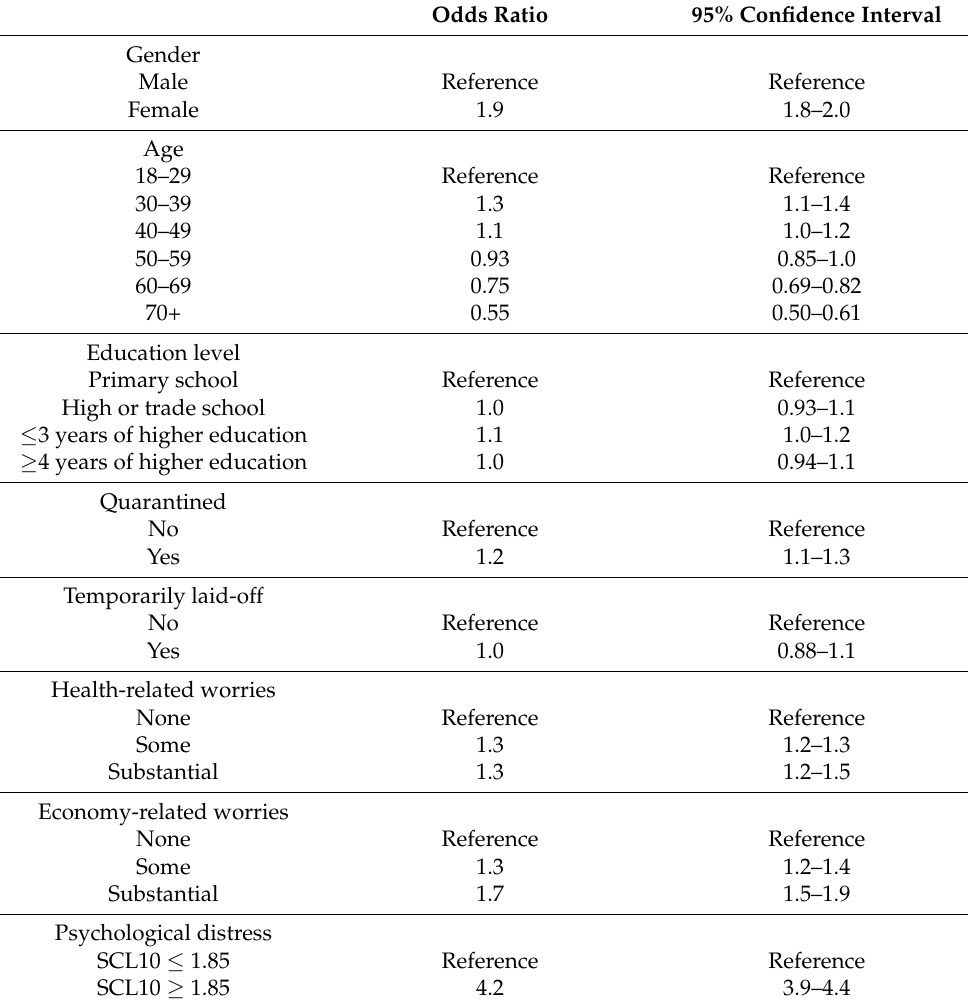
Table 2. Ordered logistic regression of emotional eating by predictors including COVID-19-related worries and psychological